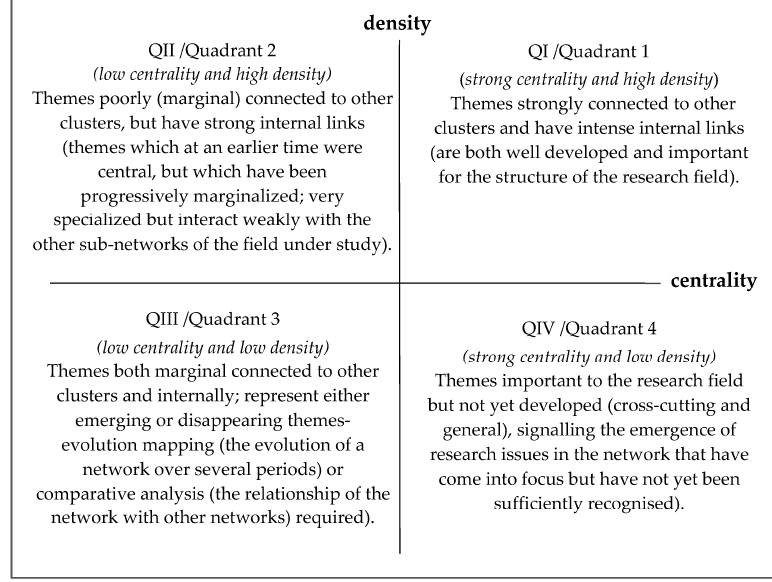
Figure 3. Two-dimensional strategy diagram with quadrant description.